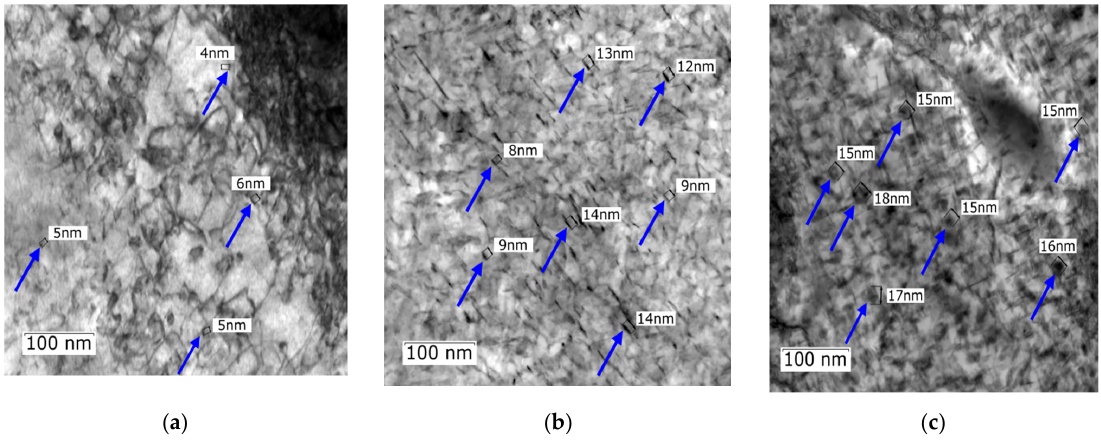
Figure 8. ( a ) Detailed TEM view of precipitate particles across the cross-section of sample 2 aged at 420°C/6h, ( b ) TEM view of sample 5 aged at 480 °C/6 h, ( c ) TEM view of sample 7 aged at 520 °C/6 h.